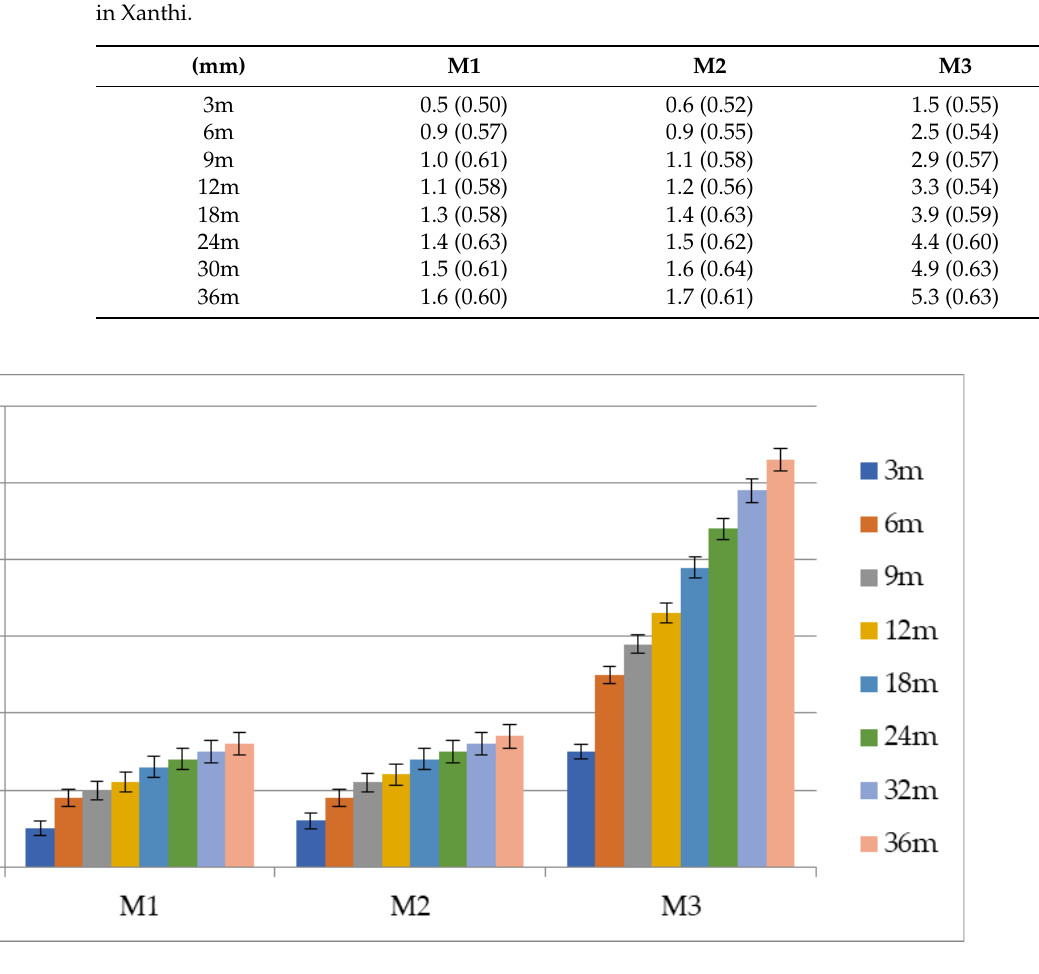
Figure 9. Depth of natural carbonation of mortar mixtures exposed to the outdoor environment of Xanthi.